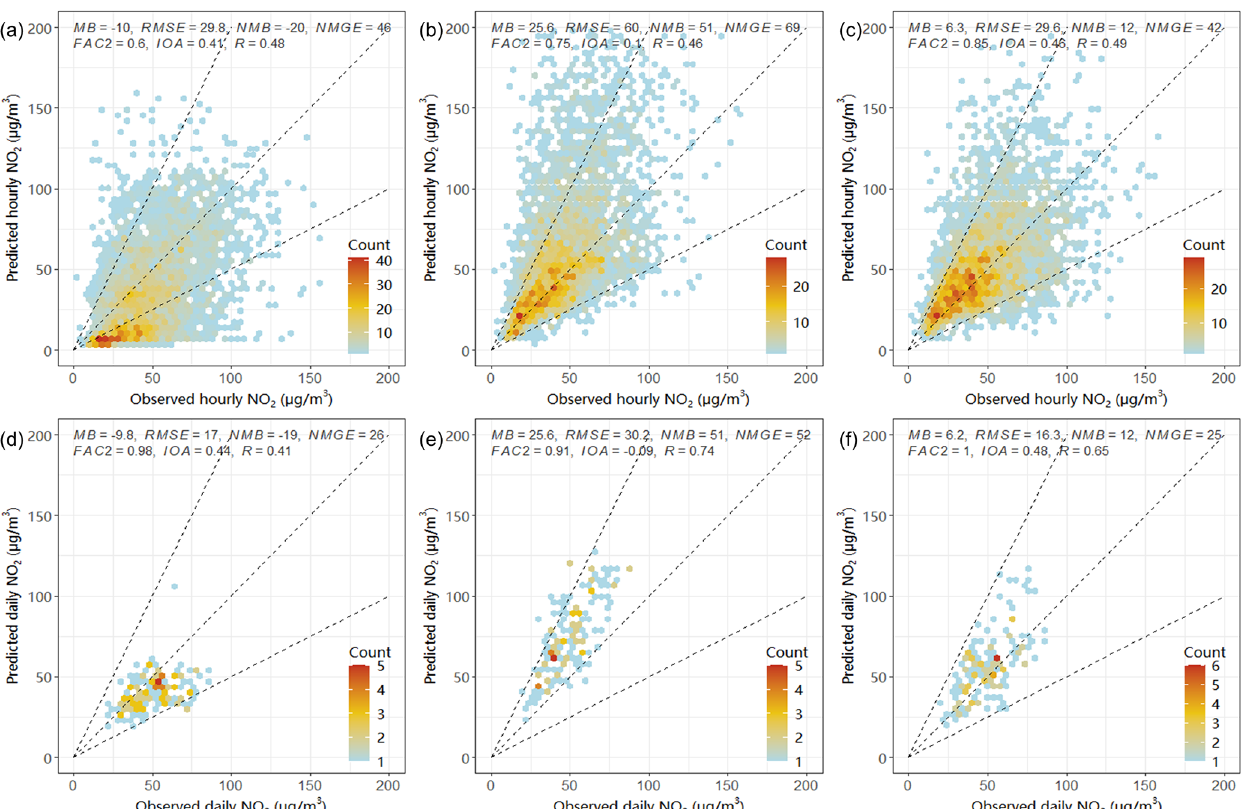
Figure 10. Observed and predicted hourly (a–c) or daily averaged (d–f) NO 2 concentrations from different models at near-road sites: (a,